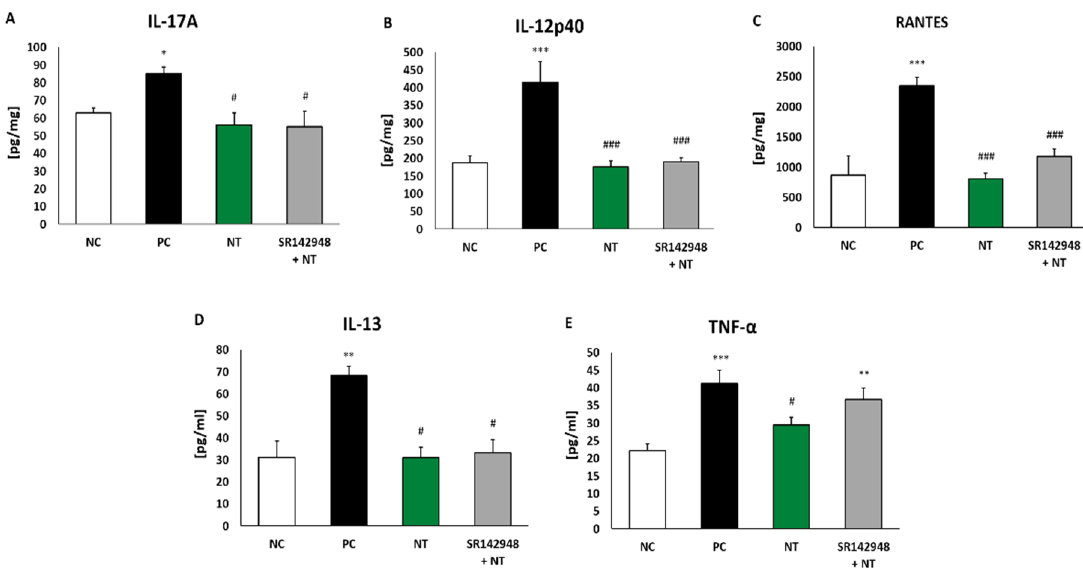
Figure 3. Pro-inflammatory cytokine concentrations in lung tissue homogenates: IL-17A ( A ), IL-12p40 ( B ), RANTES ( C ) and in BALF: IL-13 ( D ) and TNF-α ( E ) after treatment with NT alone and NT pretreated with SR 142948. Comparison to DNFB-sensitized/DNS-challenged group (positive control; PC) and vehicle-sensitized/DNS-challenged group (negative control; NC) treated with NaCl. The results are presented as means ± SEM; n = 5–7 mice per group. * p < 0.05, ** p < 0.01, *** p < 0.001 compared with the NC group; # p < 0.05, ### p < 0.001 compared with the PC group.